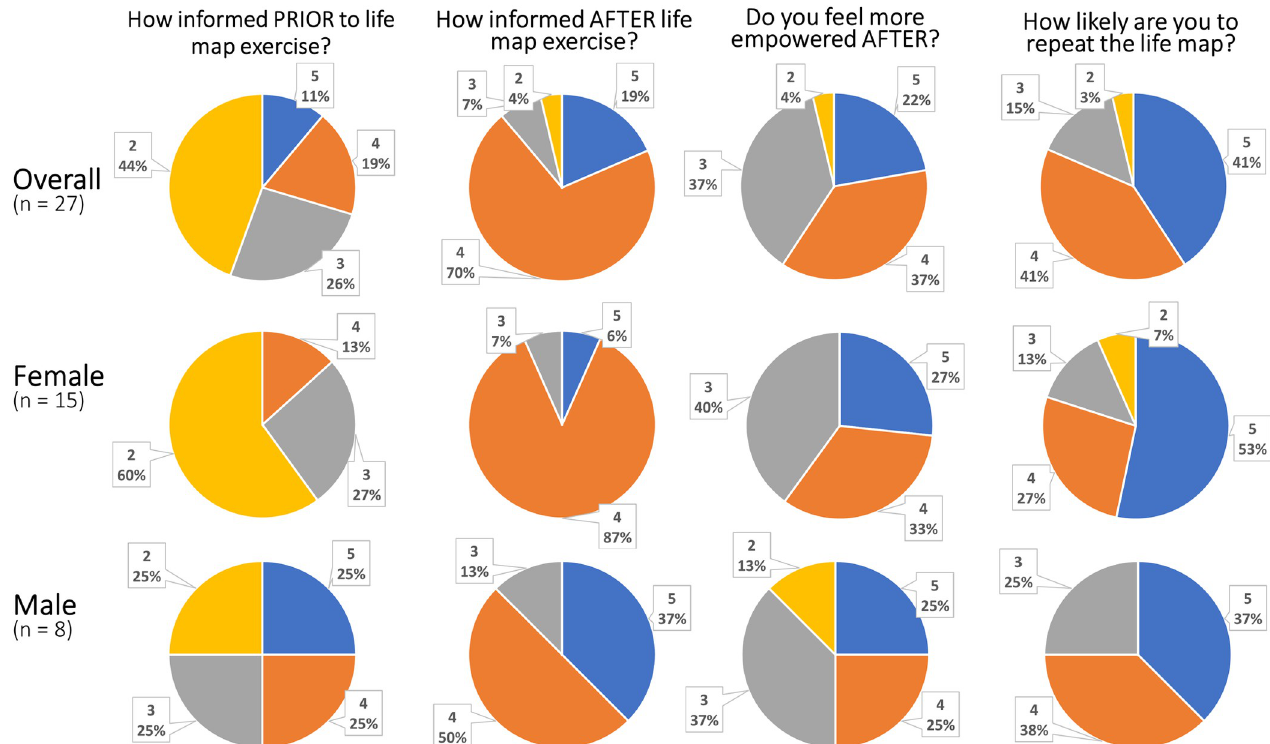
Fig 3. Participant rating of the outcomes of the Future Life Map exercise. This shows the distribution of responses on 5-point Likert scales of the entire group, and separated by gender for those participants who identified a gender. Number indicates Likert score and percent corresponds to percent of respondents selecting that